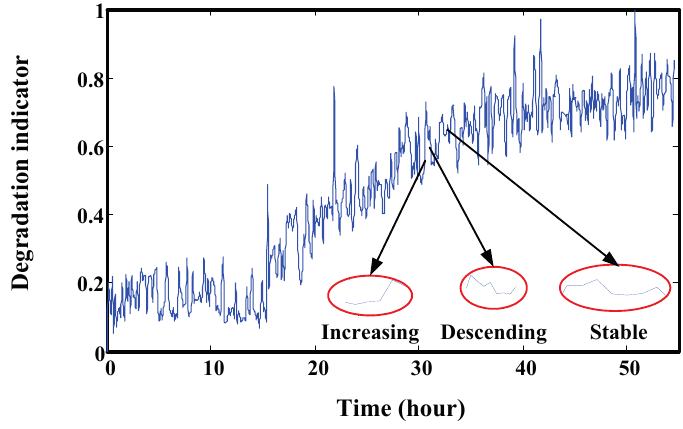
Figure 7. Three typical results from small windows: descending, increasing and